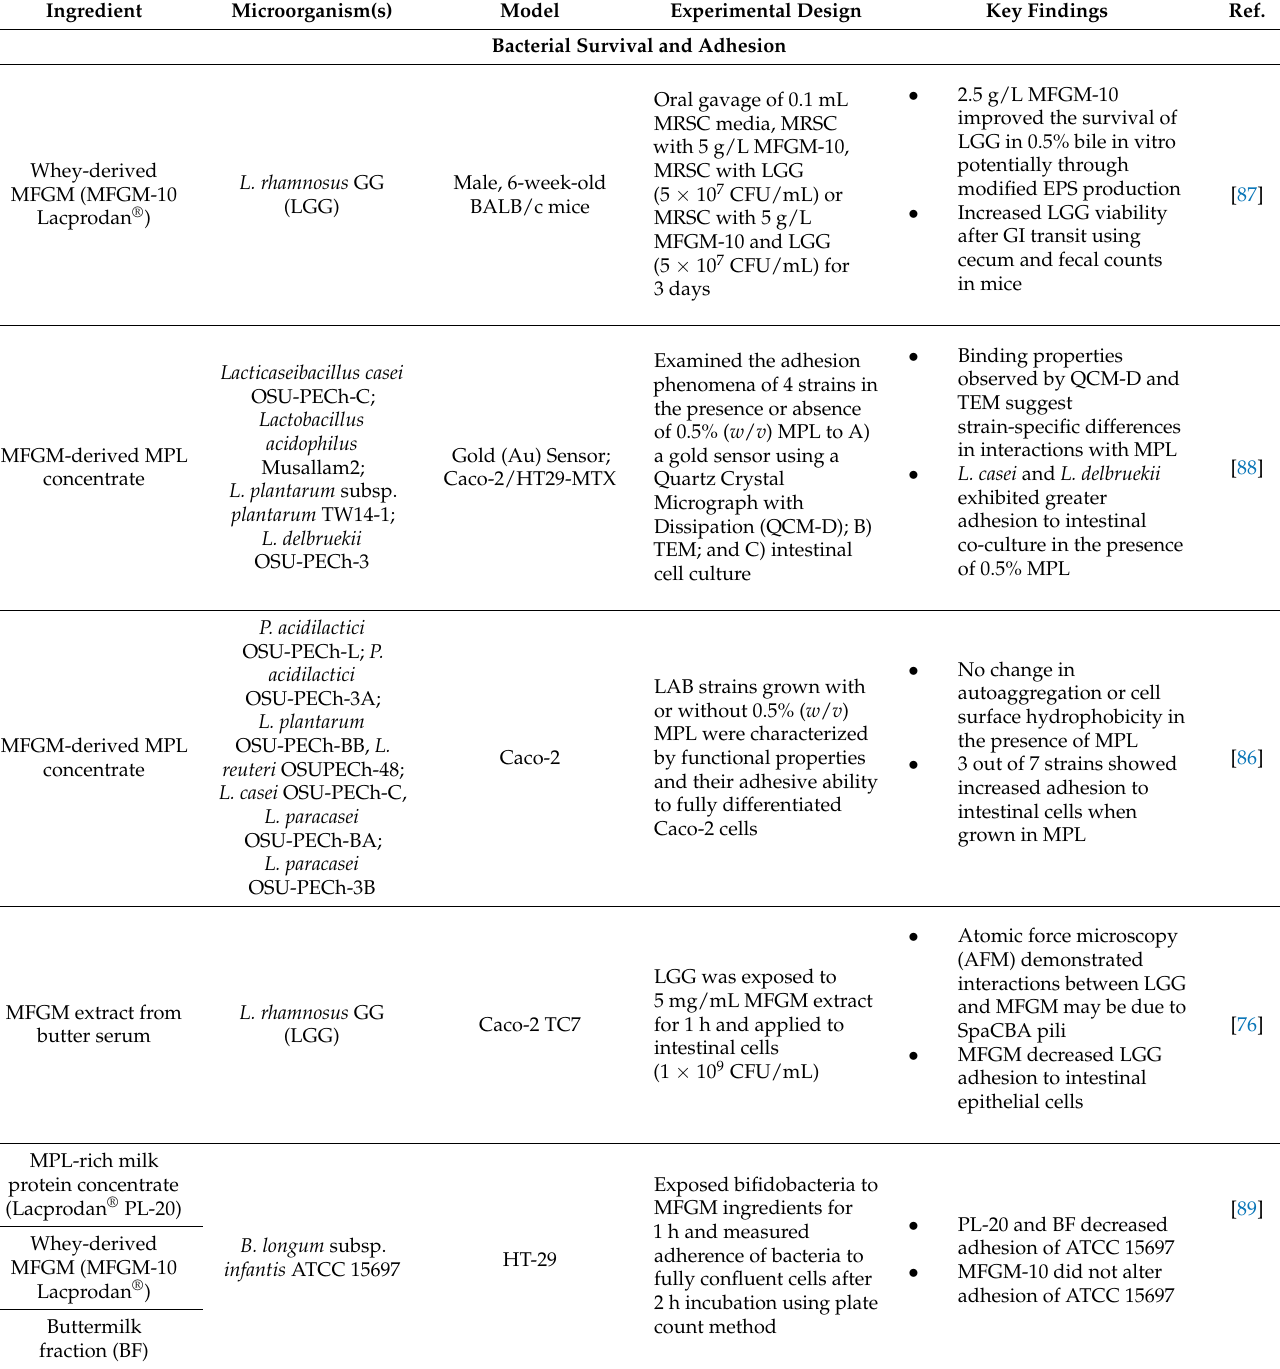
Table 4. Purported health benefits of combined probiotic and MFGM